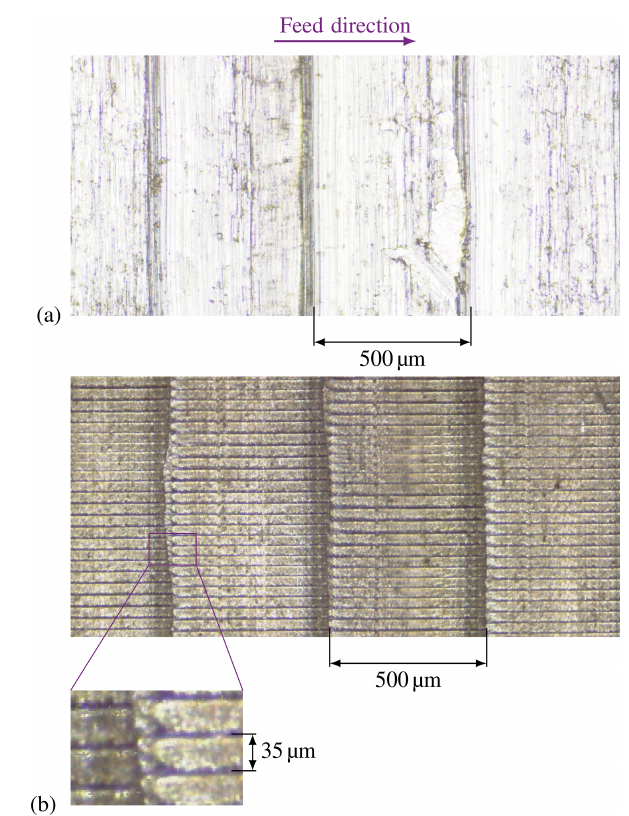
Figure 7. Resulting surface topographies from turning without (a) and with (b) ultrasonic vibration